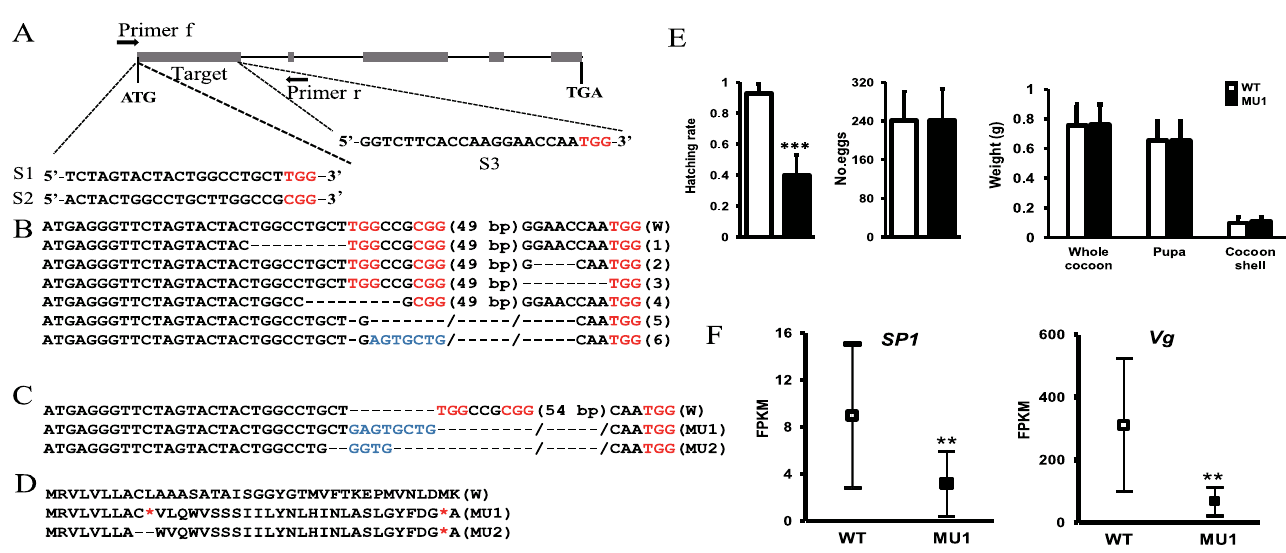
Fig 2. Cas9/sgRNA mediated gene editing of SP1 in the silkworm. (A) Schematic diagram of sgRNA targeting sites. The five boxes indicate the five exons of BmSp1 , and the black line with blocks represents the gene locus (blocks, exons; lines between blocks, introns). All sgRNA targeting sites are located on the first exon (S1, S2, and S3) and the PAM sequence is labeled in red. Sp1-F and Sp1-R were the primers used for mutation screening. (B) Various types of mutations in G0 injected embryos. Deletions are indicated by hyphens and insertions are shown in blue lowercase letters. The PAM sequence is in red. (C) Two types of mutations identified from homozygous mutant silkworms. W, wild type. MU1, SP1 mutant type 1. There was an 8bp insertion followed by a 63 bp deletion in the SP1 coding sequences; MU2, SP1 mutant type 2. There was a 4 bp insertion followed by a 65 bp deletion. (D) Comparison of inferred amino acid sequences of homozygous mutant silkworms and the wild type. The missing amino acids are replaced with dashes. Premature stop codons are shown in red asterisk. (E) Phenotype assay of the mutants. Hatching rate of SP1 mutants (MU1) decreased to about 51%. In total, 83 replicates of hatchings for MU1, 43 replicates for MU2 and 14 replicates for wild-type were used for statistical analysis. Number of egg produced, whole cocoon weight, pupa weight and cocoon layer weight, and pupa weight/whole cocoon weight ratio of mutants and wild-type silkworms, indicating no significant differences. In total, 32 replicates for mutants and 11 replicates for wild-type were used. Error bar: SD. (F) Expression level indicated as FPKM of SP1 and Vg in the ova of domestic and wild silkworms. The three data pots indicate the highest value with 95% confidence, the average and the lowest value with 95% confidence, respectively. � , �� and ��� represented significant differences at the 0.05, 0.01, 0.001 level (t-test).